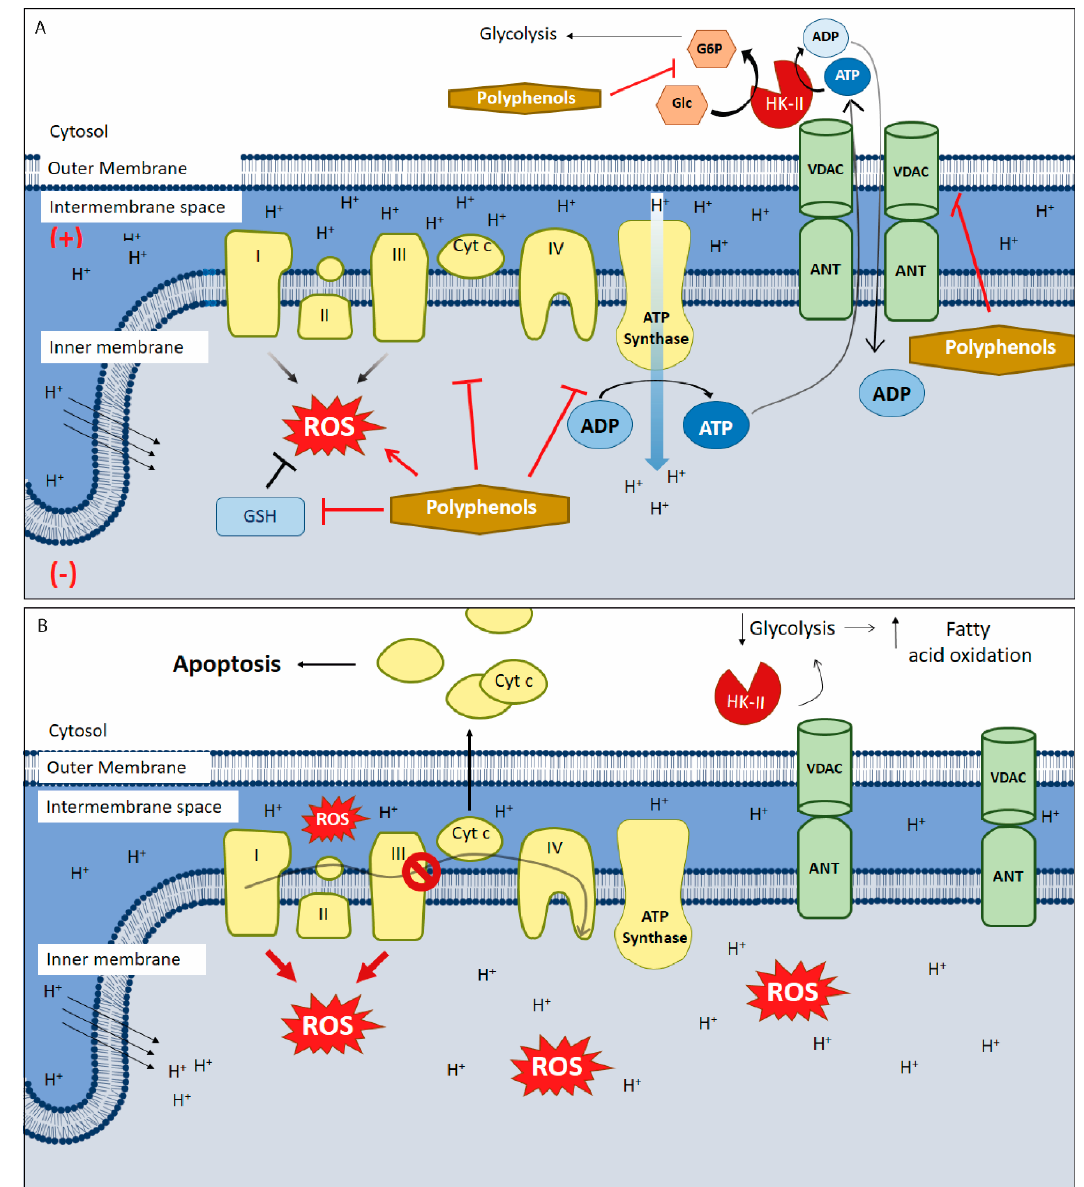
Figure 1. Polyphenols targeting mitochondria in cancer. ( A ) Polyphenols alters oxidative stress through the generation of intracellular reactive oxygen species (ROS) by di ff erent pathways: autoxidation, inhibiting antioxidant pathways and downregulating the modulate electron transport chain (ETC) function both directly or indirectly (e.g., by inhibiting aerobic glycolysis). They also inhibit ATP synthase, HK-II activity, and blocks the voltage-dependent anion channel (VDAC). ( B ) HK-II / VDAC complex uncoupling causing a drop in glycolysis and in the amount of ADP in the mitochondrial matrix. To compensate the lack of ATP availability, a metabolic switching occurs and metabolism changes towards fatty acid oxidation, inducing (more) ROS generation, membrane permeabilization, inner membrane depolarization and apoptosis. Furthermore, polyphenols inhibit the anti-apoptotic proteins of the bcl-2 family, allowing the exit of Cyt-c from the mitochondria triggering intrinsic apoptosis. This scheme does not include the anti-oxidant mechanisms of polyphenols. ( + ) positive charge in mitochondrial intermembrane space; ( − ) negative charge on the matrix side of the inner mitochondrial membrane; red arrows: ROS synthesis increases; inhibitory red lines: inhibitory e ff ects of polyphenols; ↑ increases; ↓ decreases; Ø complex III